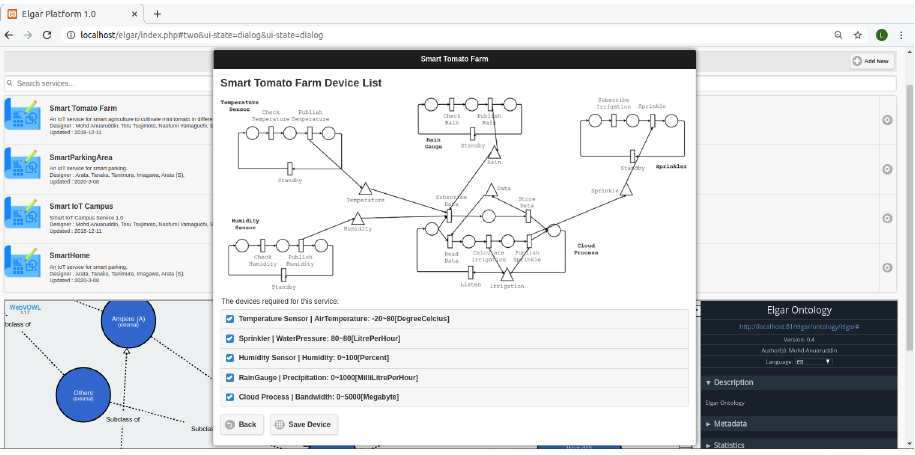
Figure 11. Service Design and service implementation